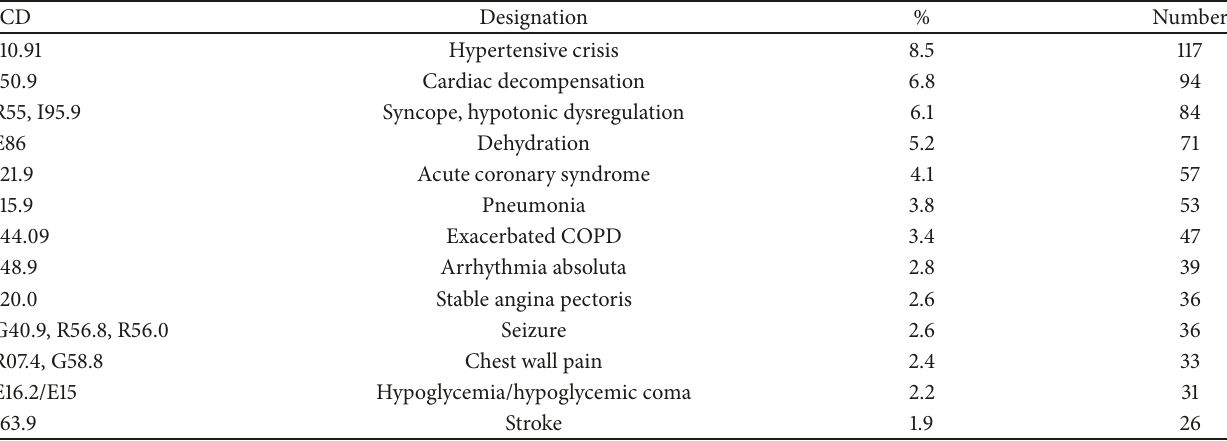
Table 1: The 13 most common prehospital mission-related hospital discharge diagnoses by the prehospital emergency physician (n = 1378).